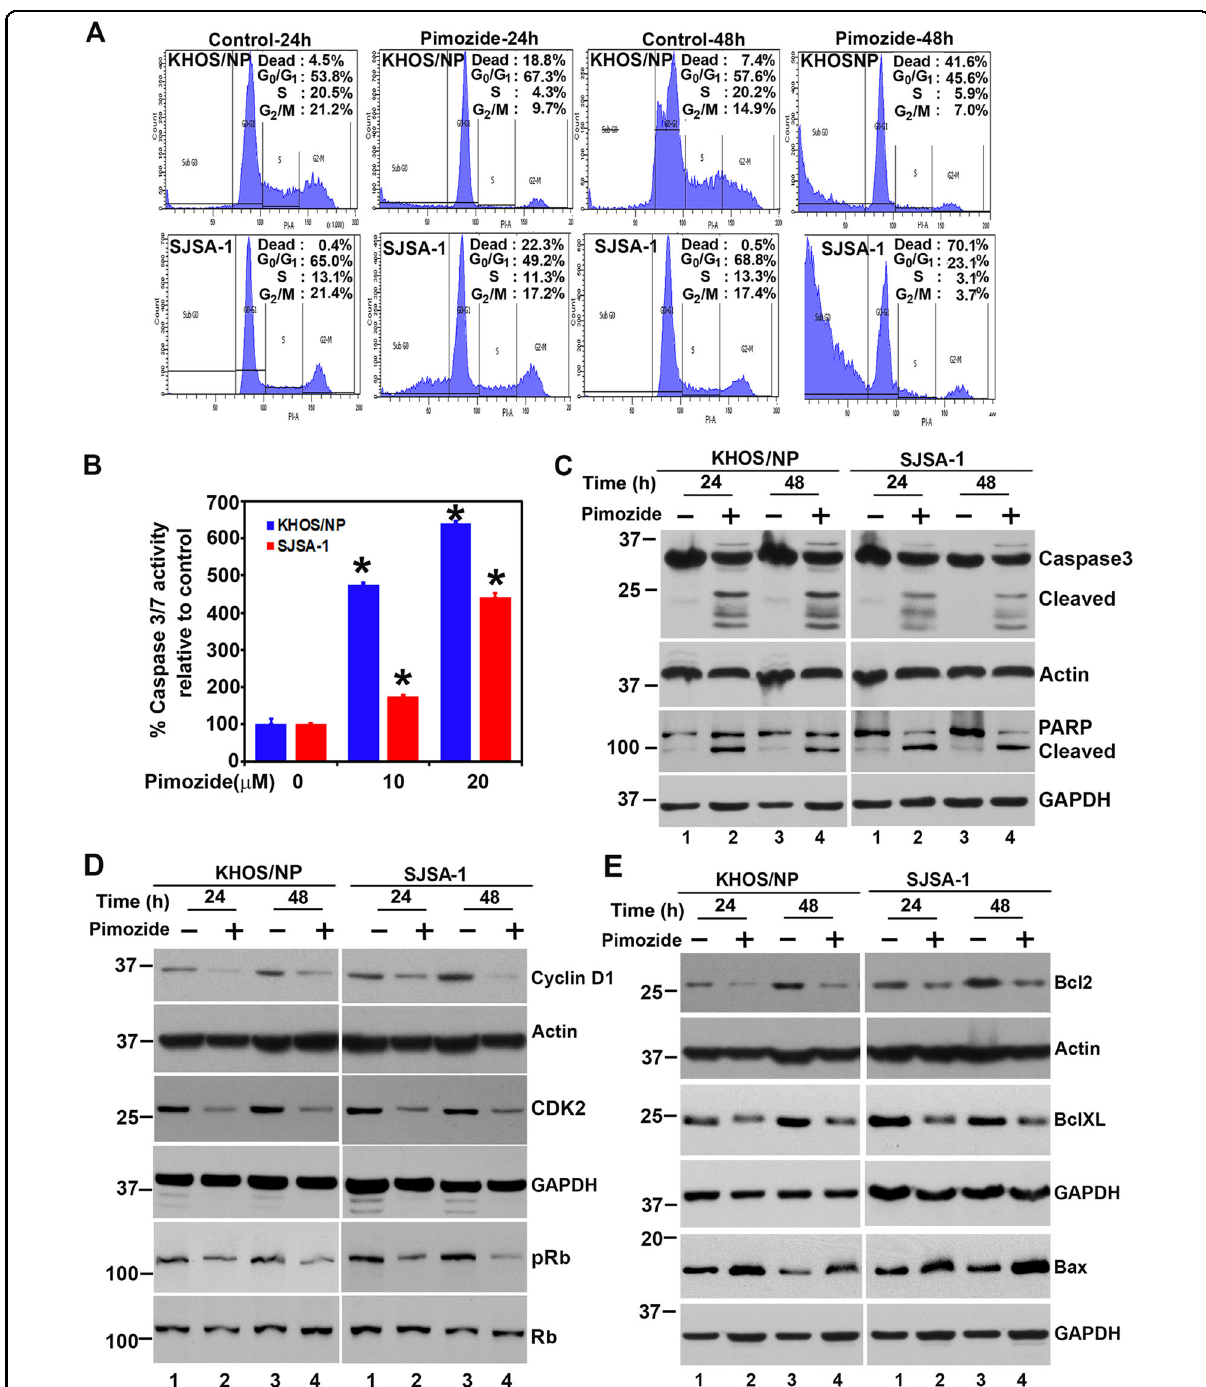
Fig. 2 Pimozide induces cell cycle arrest and apoptosis. a Cell cycle analysis of pimozide treated cells. KHOS/NP and SJSA-1 were treated with 20 µM of pimozide for 24 and 48 h and then examined by fl ow cytometry following propidium iodide staining for DNA content. Pimozide treatment increased SubG0/G1 arrest at 24 and 48 h in both cells. b Cells were incubated with pimozide 10 and 20 µM concentration for 24 h and assessed for apoptosis by Caspase3/7 assay. Pimozide treatment results in signi fi cant increase in caspase-3/7 activity in both KHOS/NP and SJSA-1 cells (* p < 0.001). c Cells were treated with 20 μ M of pimozide for 24 and 48 h, the lysate was analyzed by western blotting for Caspase 3 and PARP protein expression. Both the cell lines showed caspase 3 cleavage and PARP cleavage following pimozide treatment. d Lysates from cells incubated with 20 µM of pimozide were analyzed by western blotting for cyclin D1, along with CDK2 and phosphorylation of RB levels. Pimozide inhibits cyclin D1, CDK2 expressions and phosphorylation of RB levels in both KHOS/NP and SJSA-1 cells. e Cells wer e treated with 20 μ M of pimozide for 24 and 48 h, the lysate was analyzed by western blotting for anti-apoptotic and pro-apoptotic proteins. Pimozide treatment resulted in decreased levels of Bcl2 and Bcl-XL expression and increased Bax expression in both KHOS/NP and SJSA-1 cells. Of fi cial journal of the Cell Death Differentiation